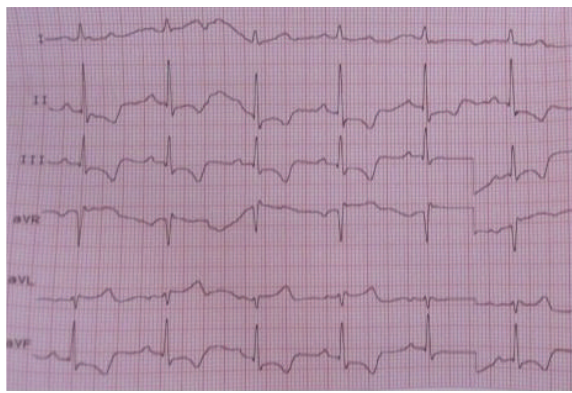
Figure 1: Negative T wave and ST segment depression on inferior derivations.